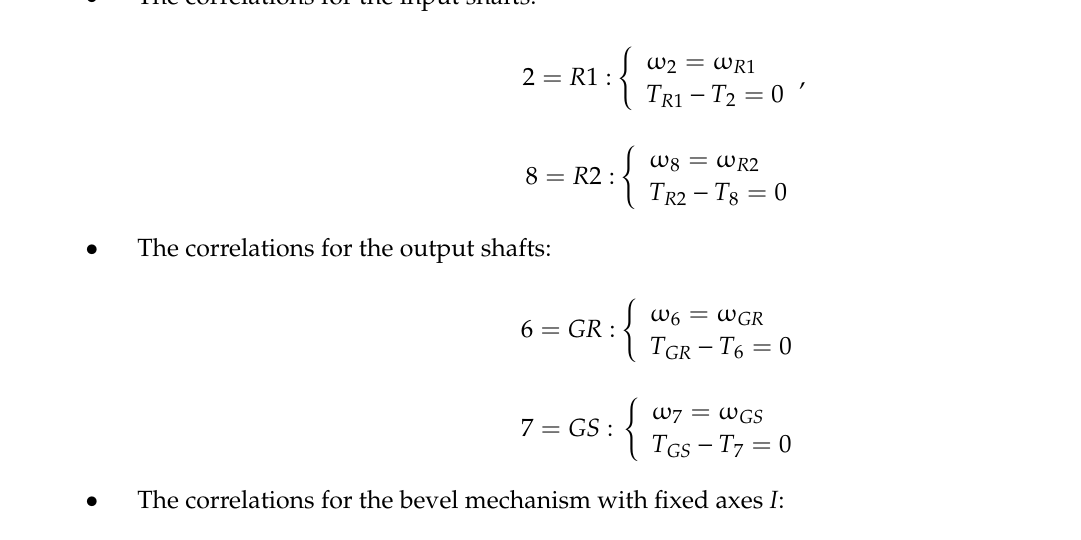
Figure 3. The block scheme of the 1 DOF planetary speed increaser.